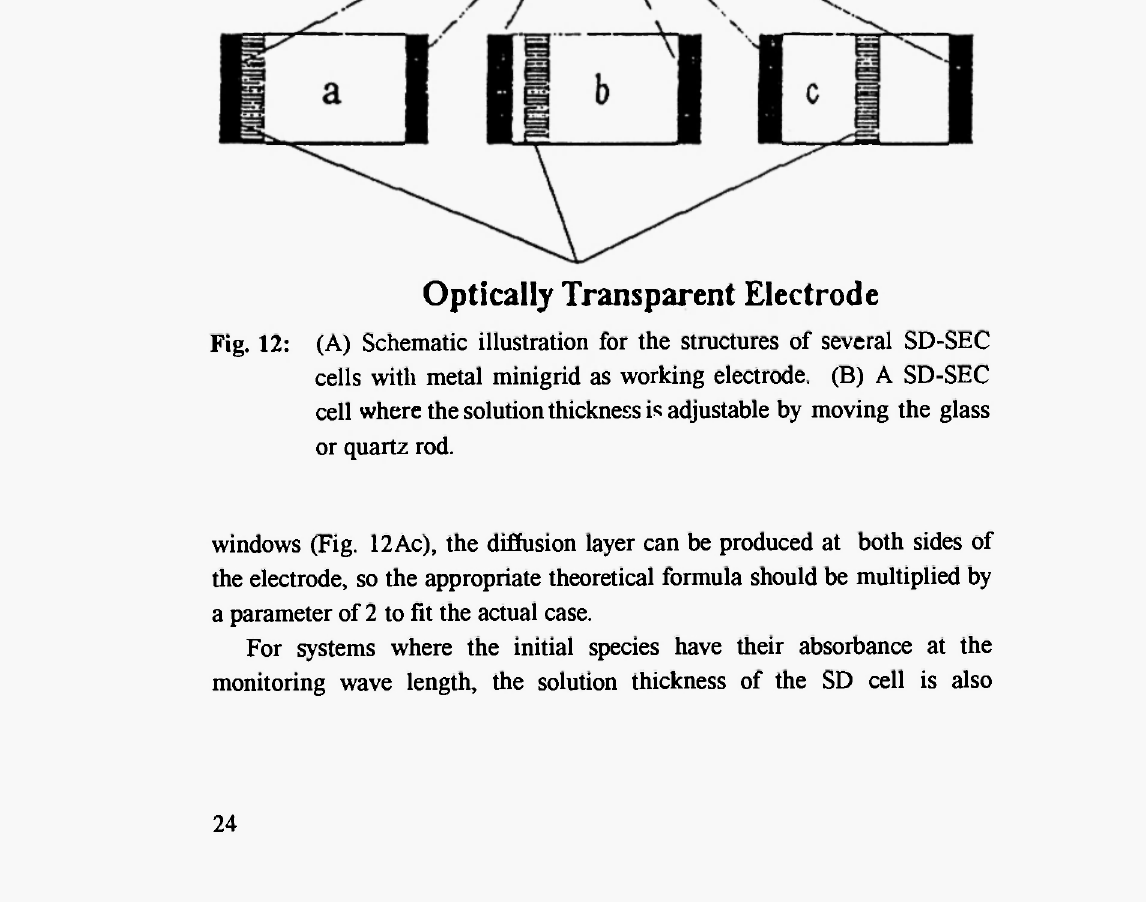
(A) Schematic illustration for the structures of several SD-SEC cells with metal minigrid as working electrode. (B) A SD-SEC cell where the solution thickness is adjustable by moving the glass or quartz